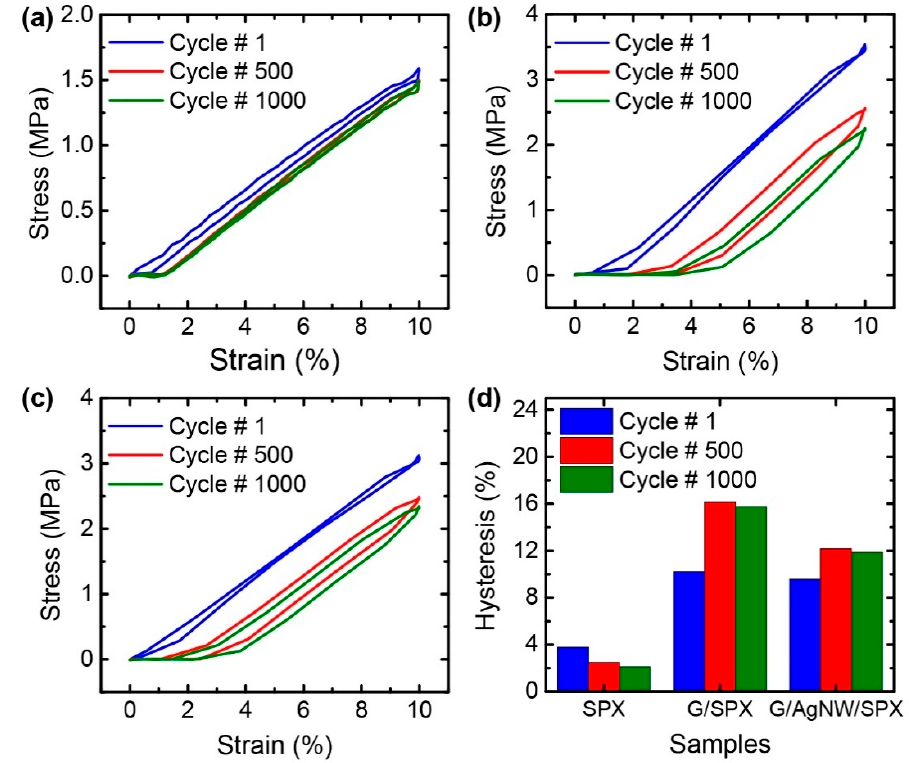
Figure 4. ( a – c ) Stress–strain curves of: ( a ) neat spandex; the ( b ) G/SpX; ( c ) G/AgNW/SpX films during the 1st, 500th, and 1000th cycles; ( d ) Mechanical hysteresis (H M ) obtained from the stress–strain curves for each film.